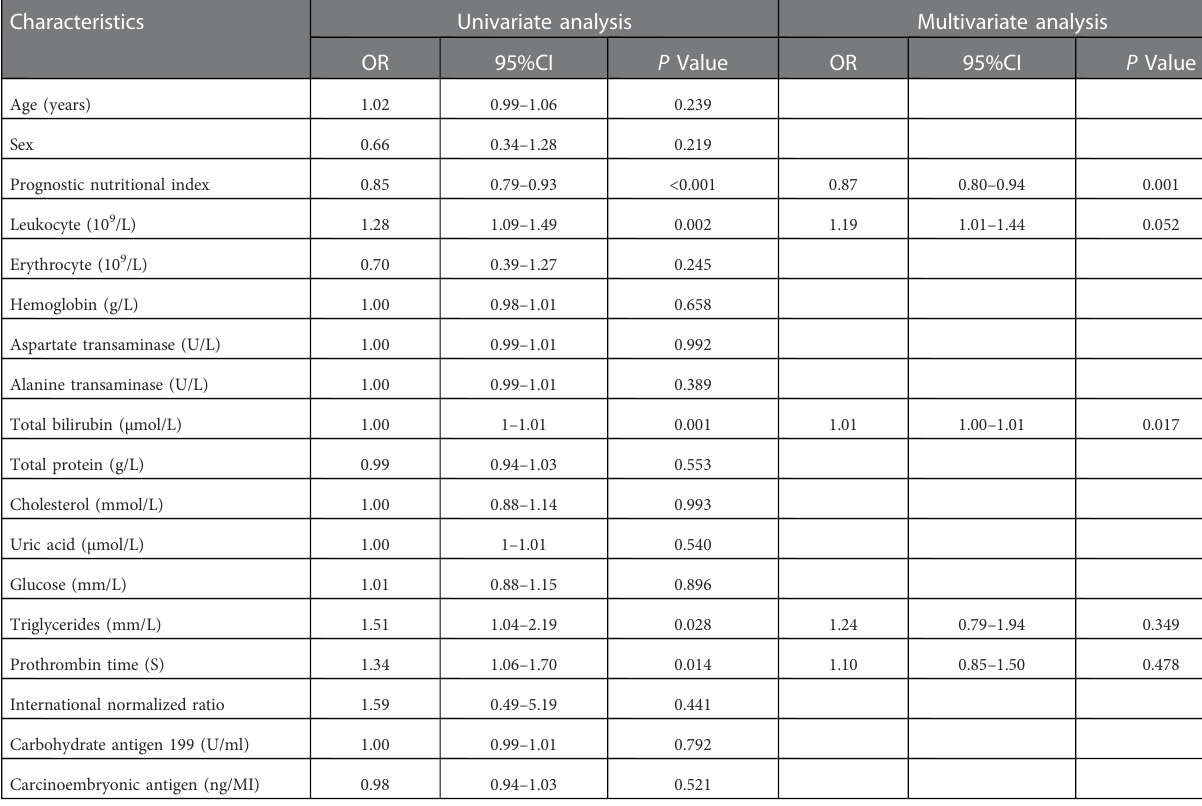
TABLE 4 Logistic regression analysis to identify risk factors for overall complications.